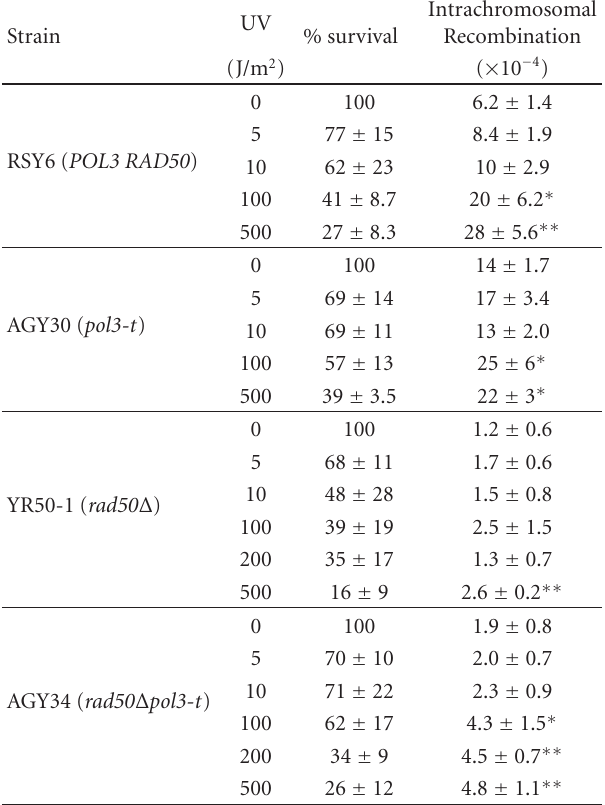
Table 5: E ff ect of pol3-t on UV-induced intrachromosomal recom- bination in RAD + and rad50 Δ strains.